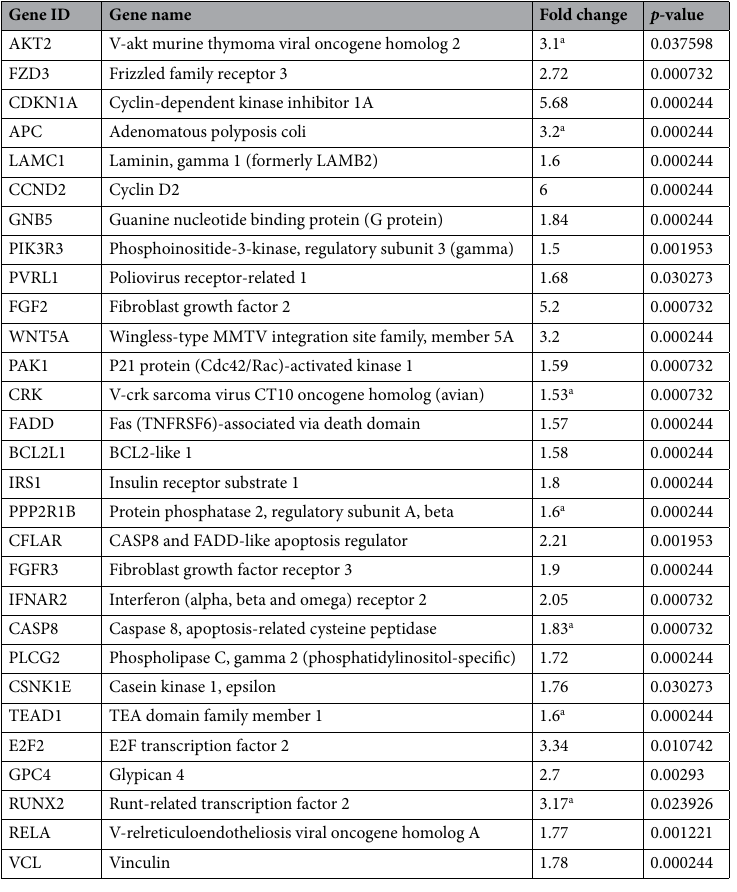
Table 3. Upregulated genes in KF-Tx cells matched in DIANA-miRNAPath pathway analysis. a Indicate that the indicated expression takes place only when KF-Tx cells were challenged with PTX. However, the other genes’ expression values (without asterisks) indicated changes in their expression in the resistant versus responsive cells without drug challenge.